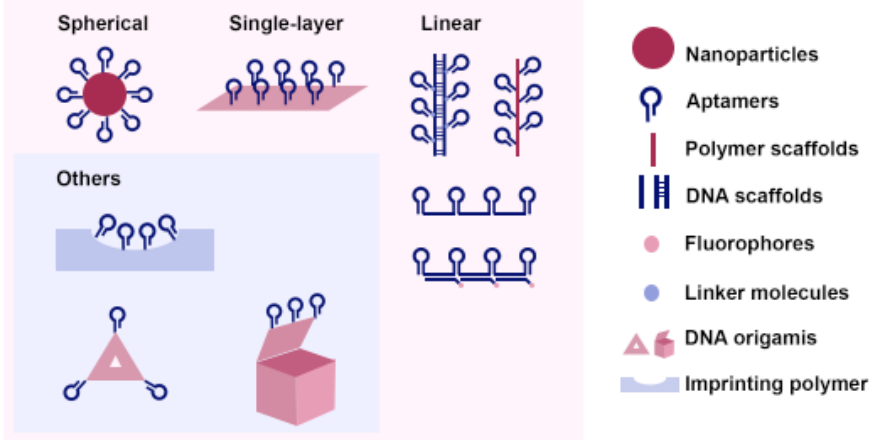
Figure 1. Schematic drawing of various structures of multivalent aptamer structures.